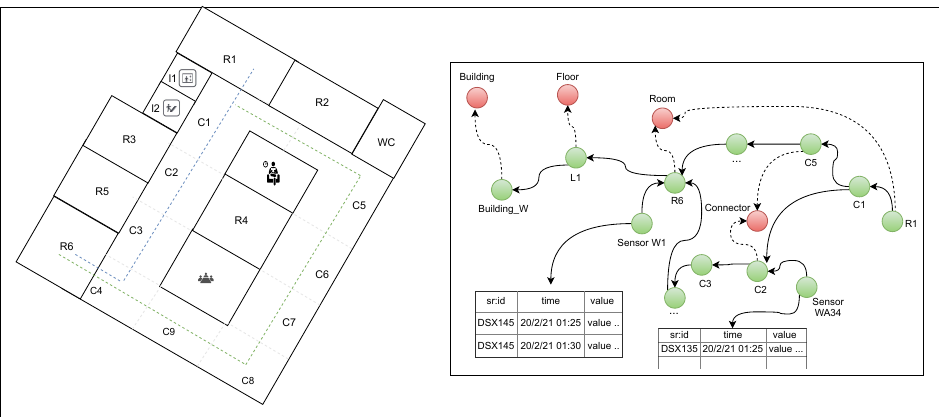
Figure 7. Example of nodes and links. Class nodes are red and instance nodes are green in